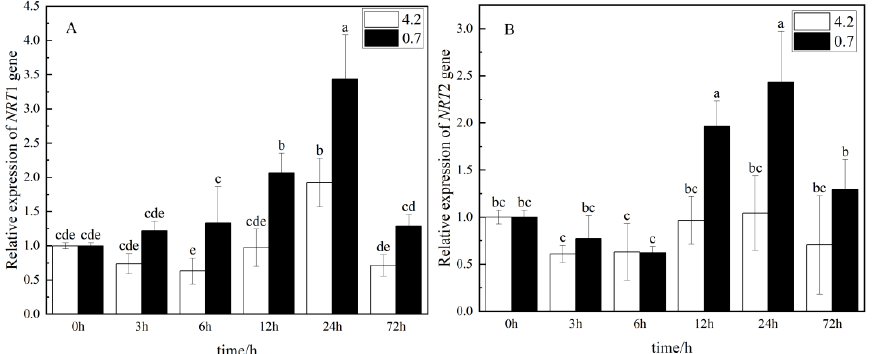
Figure 4. Expression of NRT1 and NRT2 under additional 160 mmol·L − 1 NO 3 − supplementation treatment with/without a low ratio of R:FR. 4.2: R:FR = 4.2; 0.7:R:FR = 0.7. A: Relative expression of treatment with/without a low ratio of R:FR. 4.2: R:FR = 4.2; 0.7:R:FR = 0.7. ( A ): Relative expression of NRT1; Relative expression of NRT2. NRT1; ( B ): Relative expression of